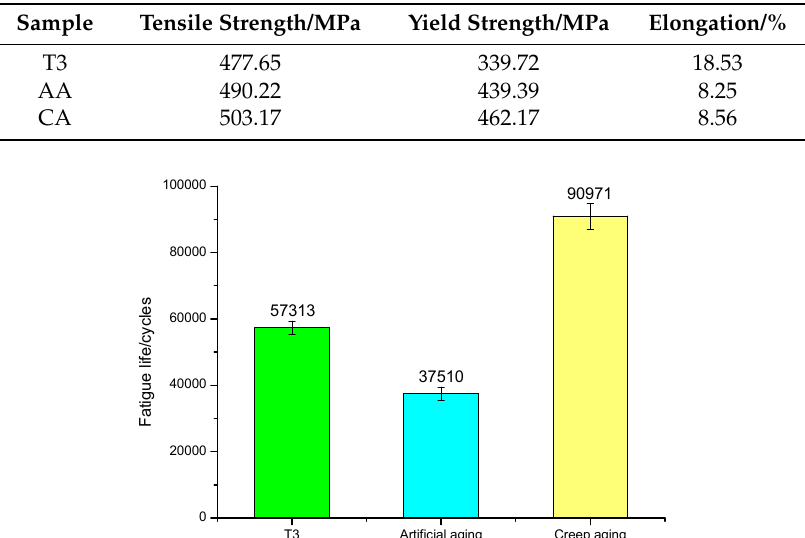
Table 1. Static tensile properties of examined alloy.